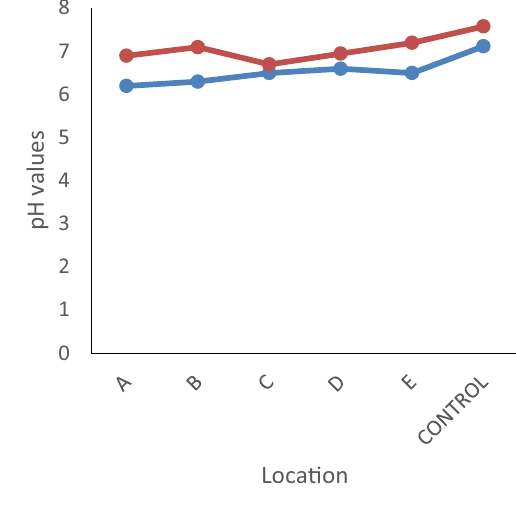
Fig. 2 The chart of pH variation across the locations